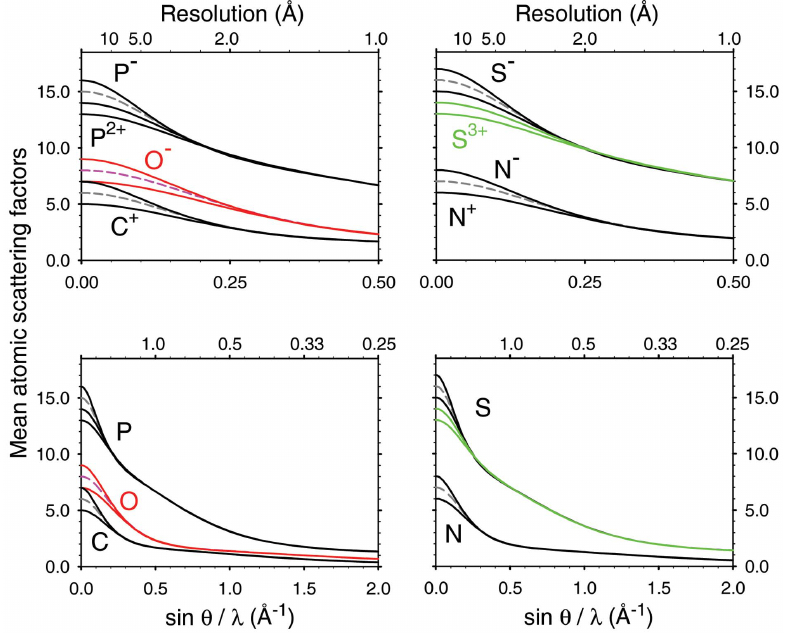
Figure 3 Plots of X-ray scattering factors obtained by our MCDF calculations. The X-ray scattering factors at sin (cid:2) / (cid:3) = 0 are equal to the number of electrons Z 0 . Dashed lines indicate plots of neutral atoms. Magenta and red curves correspond to the scattering factors of O, O + and O (cid:2) , and the green curves are those of S 2+ and S 3+ . Plots in the lower row show the same curves as those in the upper row but up to sin (cid:2) / (cid:3) = 2 A˚ (cid:2) 1 .